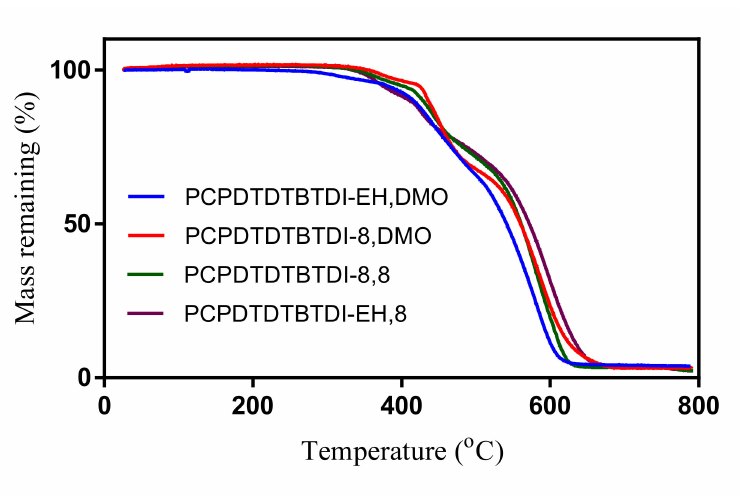
Figure 3. TGA of PCPDTDTBTDI-EH, DMO, PCPDTDTBTDI-8, DMO, PCPDTDTBTDI-8, 8, and PCPDTDTBTDI-EH, 8.